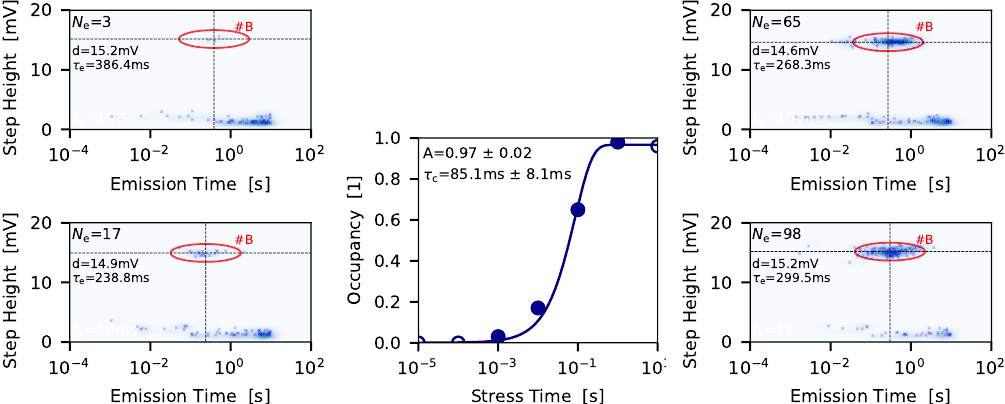
Figure 9. To extract the charge capture time a series of spectral maps ( left and right images) for sequentially increasing stress times is recorded. From each spectral map the occupancy, that is, the ratio between the number of emission events of a certain defect and the number of traces measured, can be extracted. The occupancy follows an exponential behavior ( middle ) enabling to extract the charge capture time at a selected stress bias and device